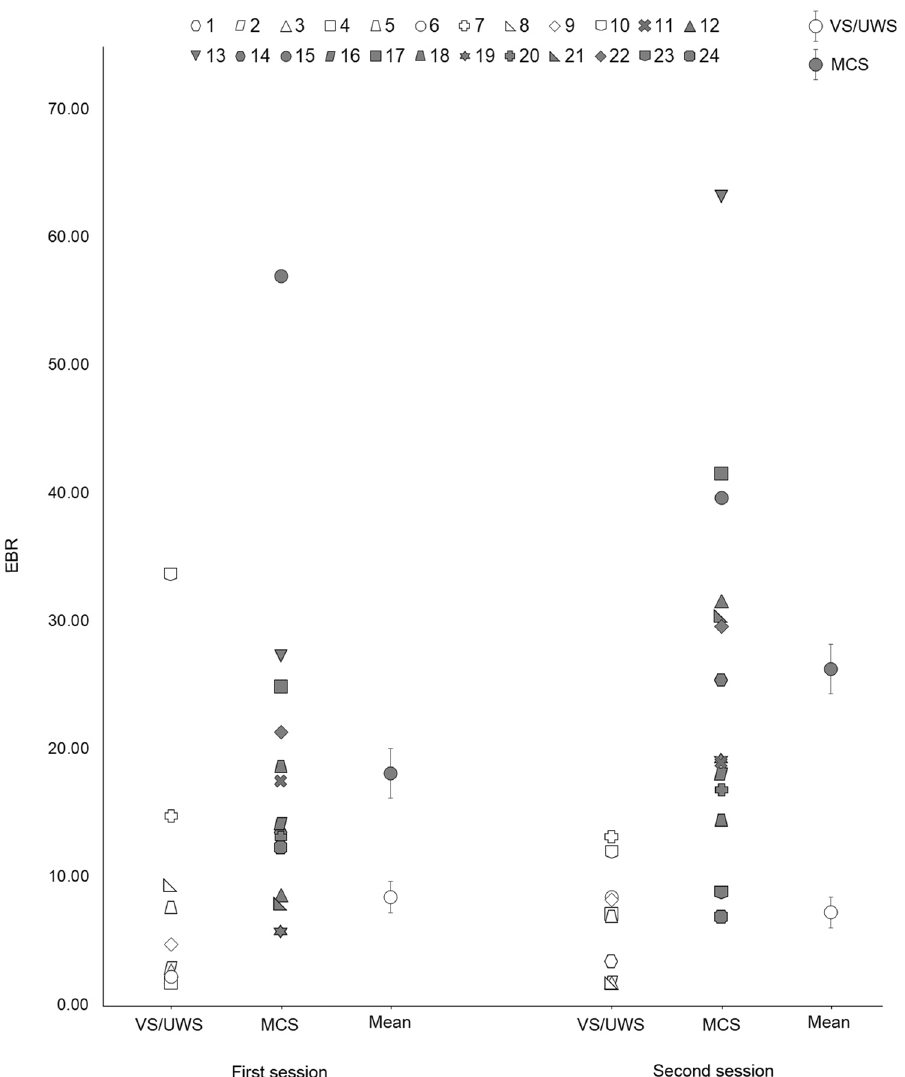
Figure 1. Patients’ mean and individual EBR as a function of the session (first, second) in the two diagnostic groups (VS/UWS, MCS). The void symbols depict patients in VS/UWS, whereas the filled symbols refer to patients in MCS. Error bars display standard errors corrected for within-subject design. Abbreviations: EBR = Eye Blink Rate; VS/UWS = Vegetative State/Unresponsive Wakefulness Syndrome; MCS = Minimally Conscious